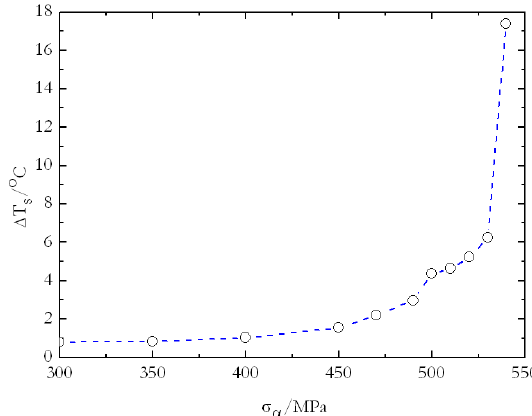
Figure 3: Temperature increment at different stress amplitude.